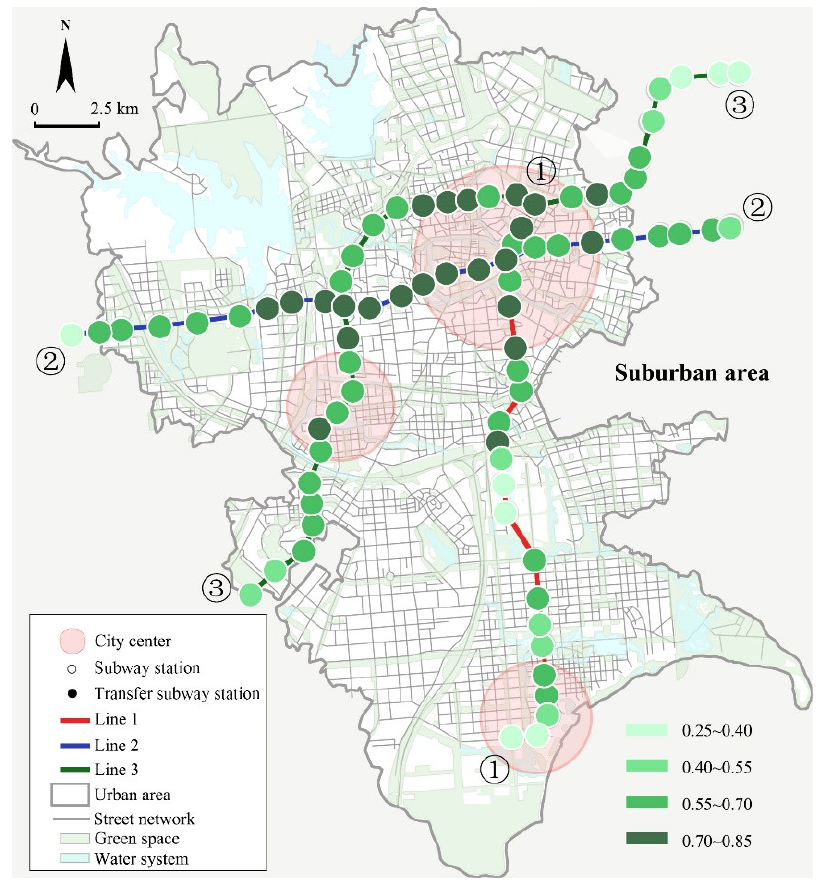
Figure 5. Map of node-values in Hefei City. The minimum distance from each station to the middle line of the node–place graph can be calculated based on the node- and place-values already obtained, and the range of distance was from 0.0024 to 0.3523 in Hefei City. Then, the silhouette coefficient was used to determine the priority development level at each TOD. The silhouette score was largest when the number of clusters was four, which indicates that it is suitable to divide 77 TODs into 4 clusters. The priority levels of the clusters depend on their distance from the middle line. Level 1 in Figure 7 has the highest development priority. Figure 7 shows the distribution of the four priority levels in the node–place model. There is only one TOD at priority level 1. There are 14 TODs in priority level 2, 30 TODs in priority level 3, and 32 TODs in priority level